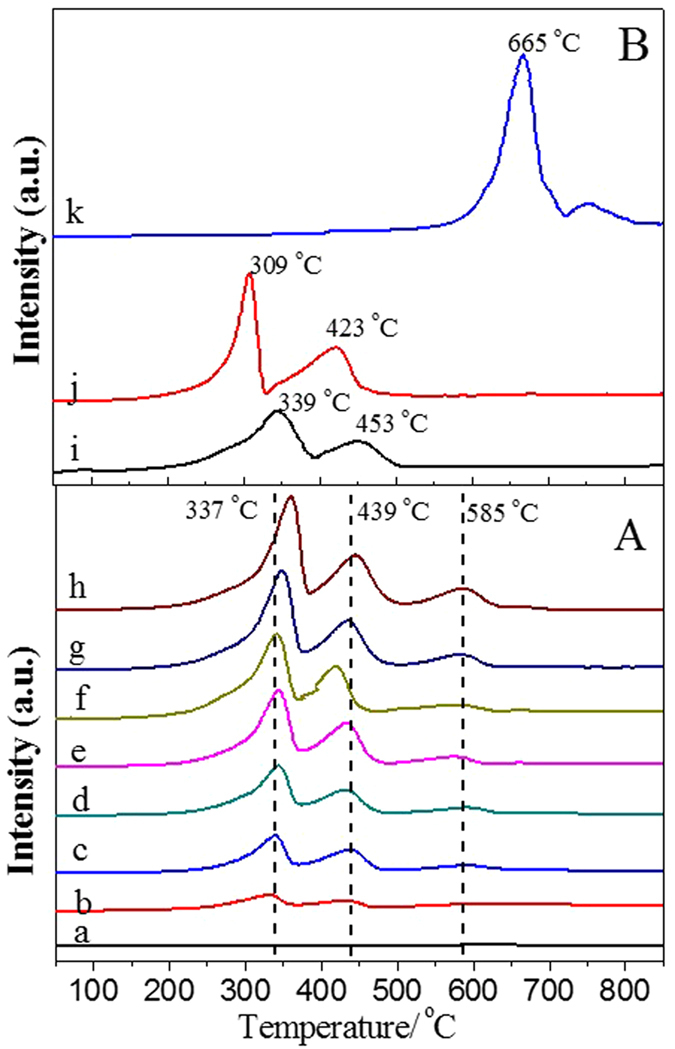
H2-TPR curves of as-prepared catalysts.(A) K-OMS-2/SiO2 obtained at varied K-OMS-2 loadings: SiO2 (a), K-OMS-2/SiO2-10 (b), K-OMS-2/SiO2-20 (c), K-OMS-2/SiO2-30 (d), K-OMS-2/SiO2-40 (e), K-OMS-2/SiO2-50 (f), K-OMS-2/SiO2-60 (g) and K-OMS-2/SiO2-70 (h); (B) different support and active components on the 3DOMSiO2: K-OMS-2/silica gel-50 (i), MnOx/SiO2-50 (j) and KNO3/SiO2-50 (k).